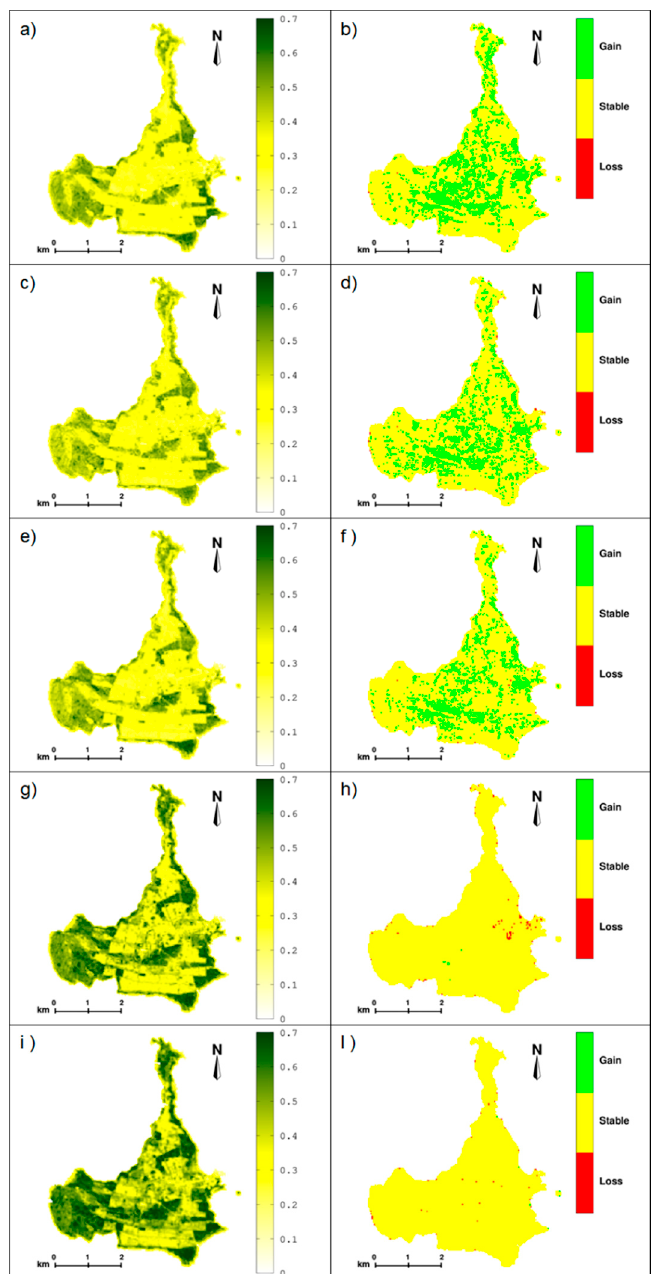
Figure 4. Multitemporal surface reflectance (SR) normalized difference vegetation index (NDVI) images (left, panels a , c , e , g , i ) and relative changes in vegetation cover (right, panels b , d , f , h , l ) during the years 1999 ( a , b ), 2003 ( c , d ), 2007 ( e , f ), 2011 ( g , h ), and 2015 ( i , l ). Changes in vegetation cover were determined by a pixel-by-pixel comparison of the Operational Land Imager (OLI) NDVI 2015 (see Figure 3) with the Enhanced Thematic Mapper (ETM+) NDVI images of the reference years 1999 ( a , b ), Thematic Mapper (TM) 2003 ( c , d ), ETM+ 2007 ( e , f ), TM 2011 ( g , h ), and ETM+ 2015 ( i , l ). In panels b , d , f , h , and l , the pixels showing an increase ( gain ), a decrease ( loss ), or absence of changes ( stable ) in vegetation cover are marked in green, red, and yellow,